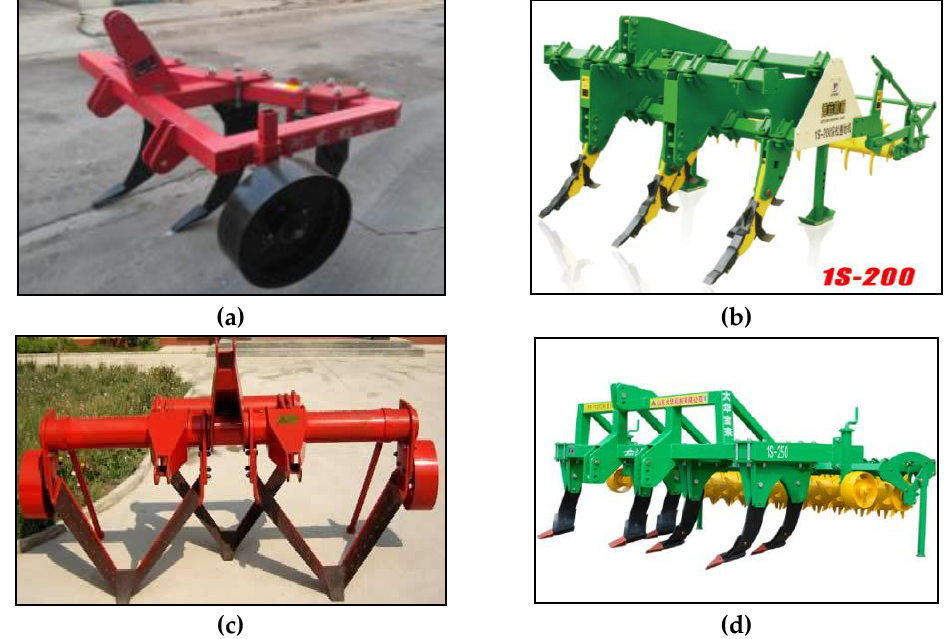
Figure 1. ( a ) Chisel shovels of the Hedongxiongfeng 1S-150A subsoiler